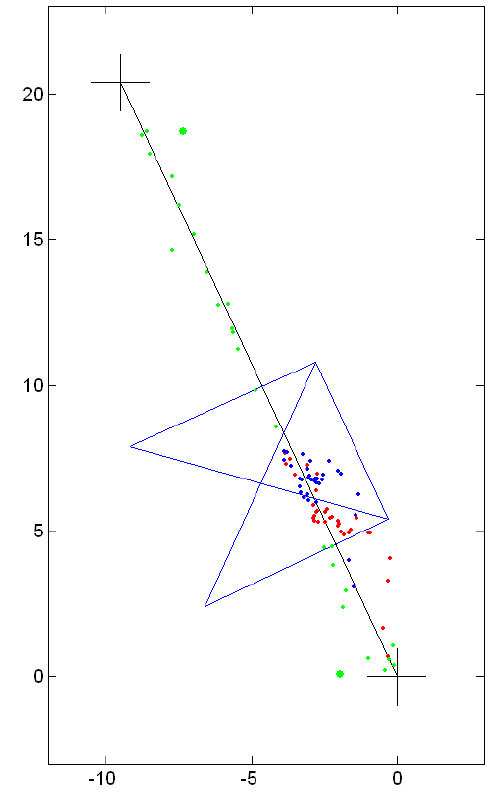
Figure 7. Conditional DGPS in environment (d): (●) cDGPS positions; (●)